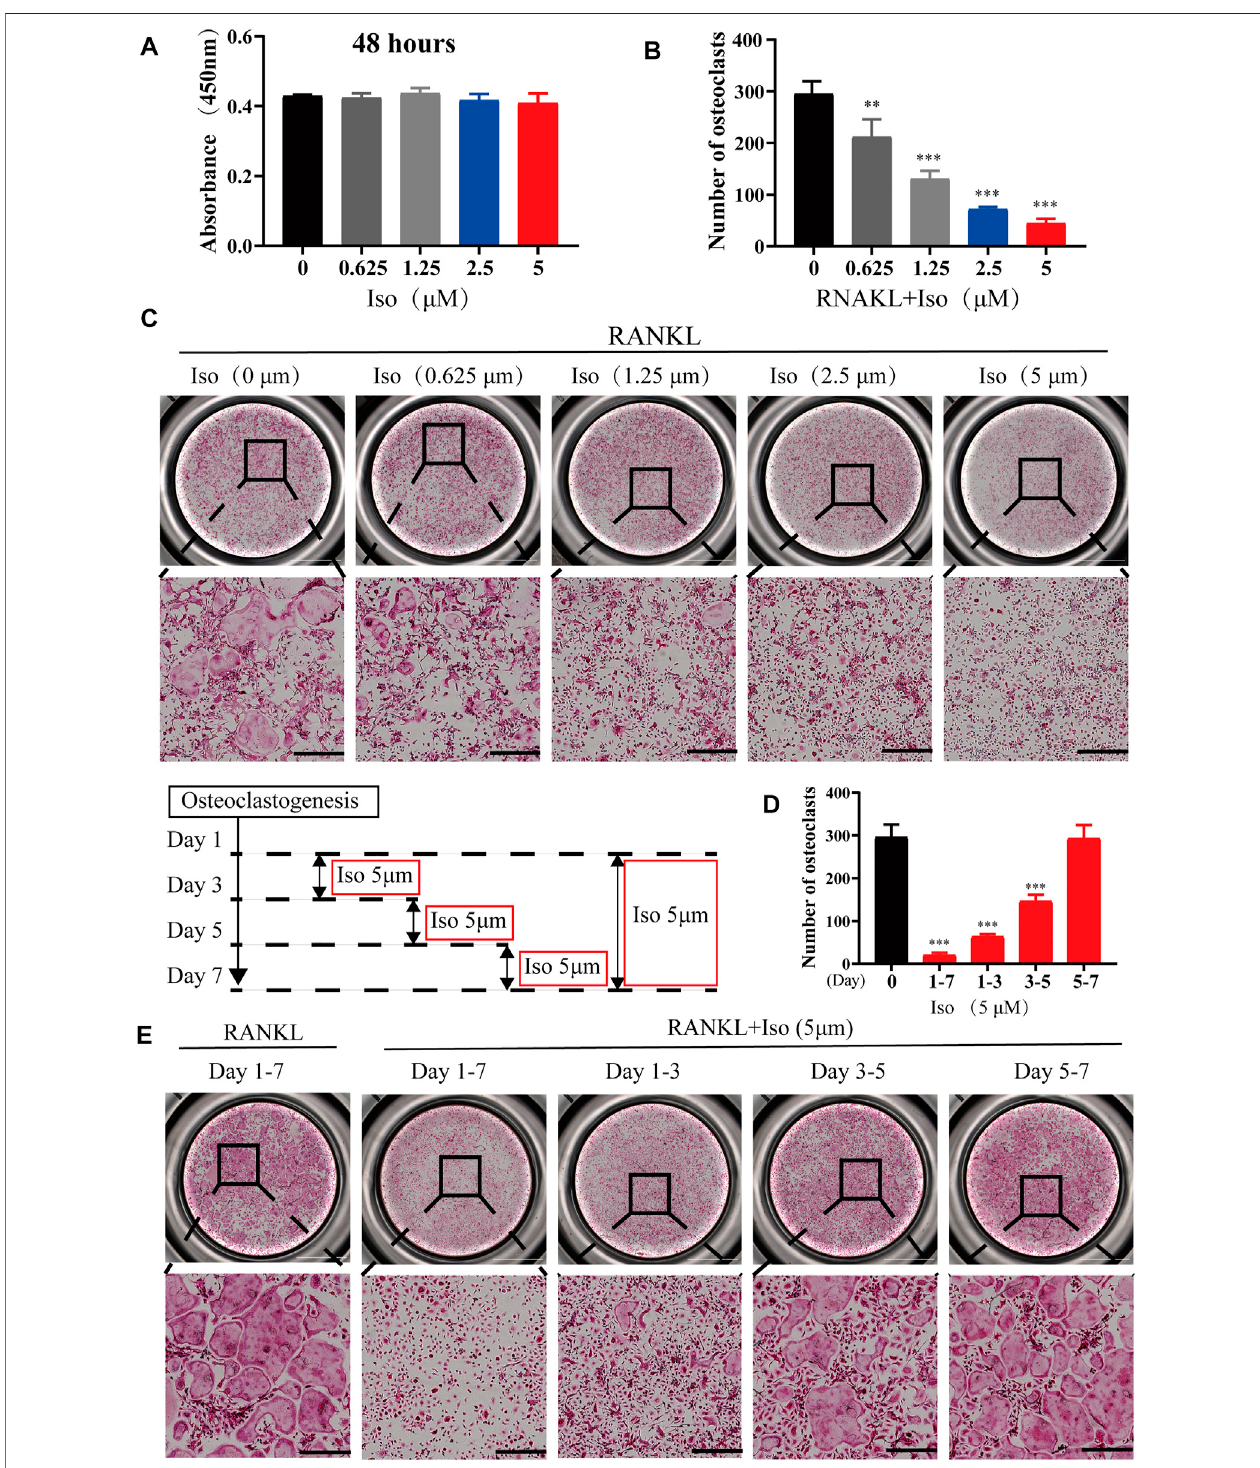
FIGURE 2 | Iso suppresses RANKL-associated osteoclastogenesis in vitro . (A) The cellular cytotoxicity of Iso was evaluated by CCK-8 assay after 48 h of incubation (B) Quanti fi cation of TRAP-positive multinucleated cells (nuclei > 3) ( n = 3 per group). (C) Representative images of TRAP staining showing that Iso inhibited osteoclastogenesis dose-dependently. BMMs were stimulated with RANKL for 5 days in the absence or presence of indicated concentrations of Iso (scale bar = 500 μ m). (D) Quanti fi cation of TRAP-positive multinucleated cells treated with Iso in different time periods ( n = 3 per group). (E) Representative TRAP stained phase-contrast images of the time-dependent effect Iso on osteoclast formation. BMMs stimulated with RANKL and treated with 5 μ M Iso on the indicated days were fi xed and stained for TRAP activity (scale bar = 500 μ m). The above data are expressed as the mean ± SD; n = 3; ** p < 0.01 and *** p < 0.001. Iso: Isoliensinine; CCK-8: cell counting kit-8; BMMs: bone marrow macrophages; TRAP: tartrate-resistant acid phosphatase; RANKL: receptor activator of nuclear factor- κ B ligand.